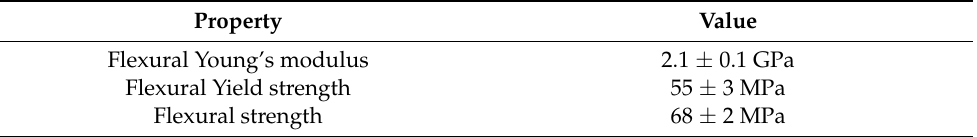
Table 1. Mechanical properties of the polyamide (PA) 2200